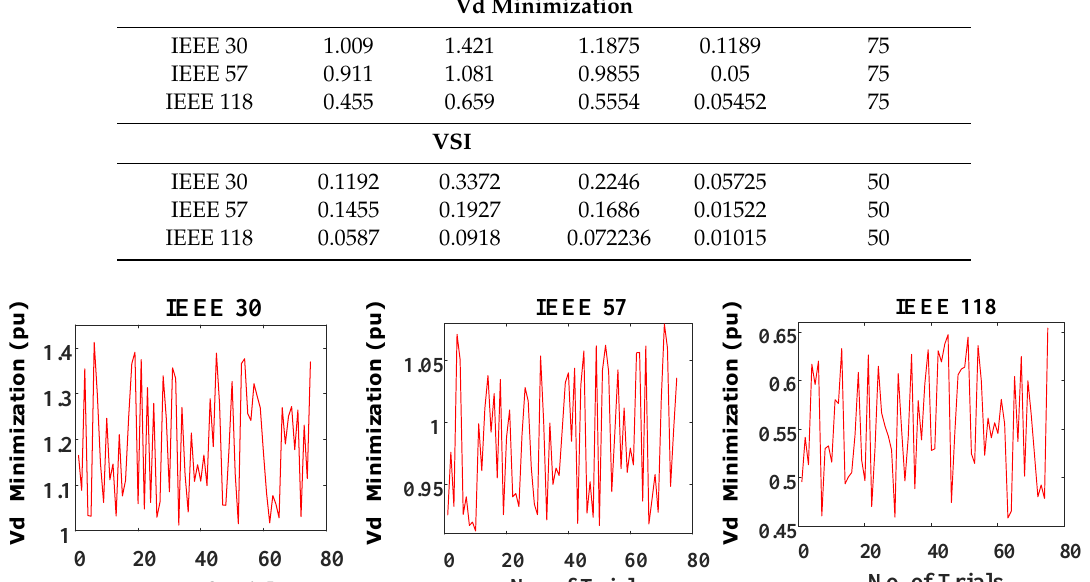
Figure 3. The obtained results of voltage deviation (Vd) for 80 trials.